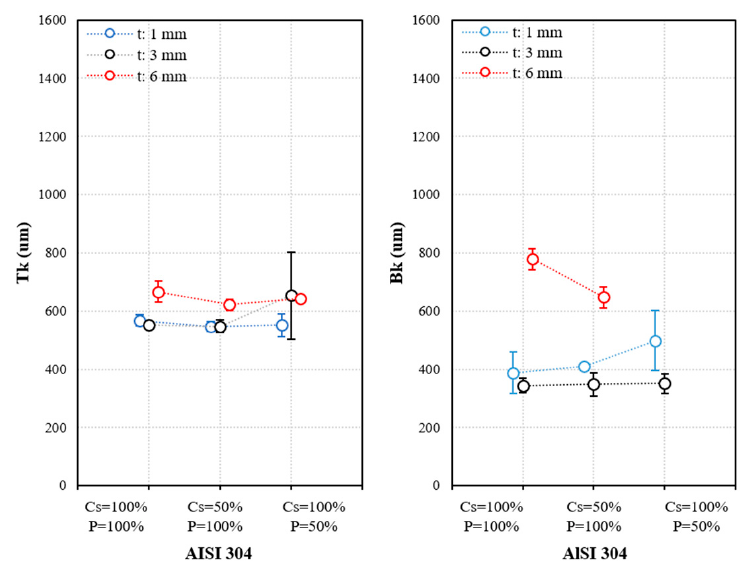
Figure 6. Kerf width for St37-2 in relation to cutting conditions and thickness.